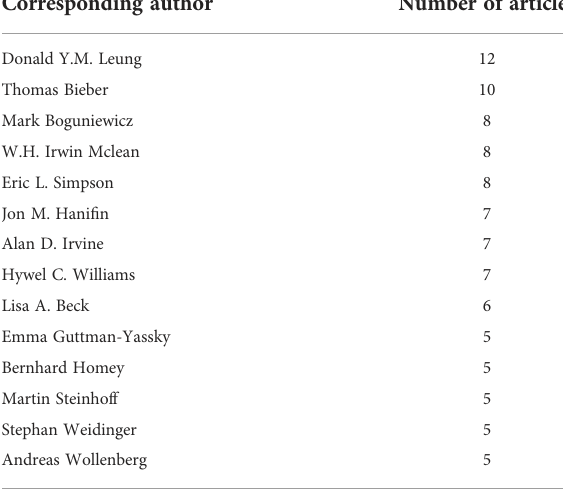
TABLE 4 Top 10 authors with the most published